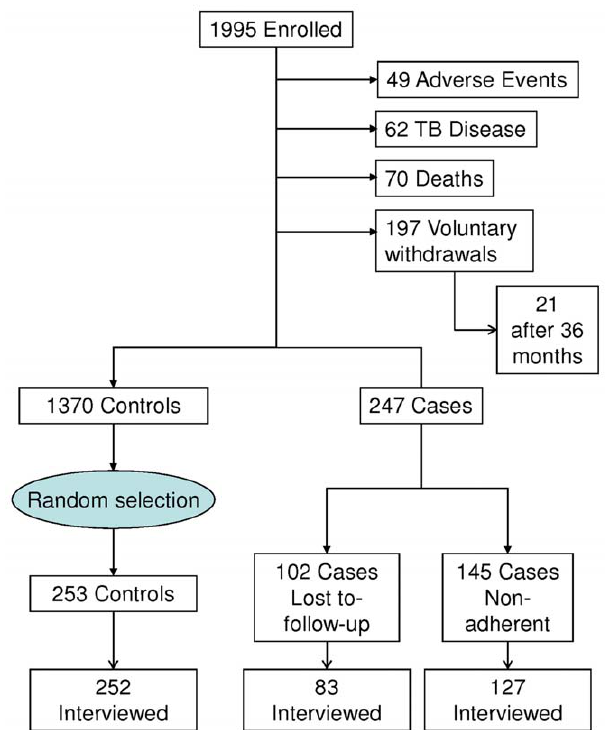
Figure 1. Derivation of cases and controls for the adherence sub-study from the cohort of HIV-infected persons enrolled in the Botswana Isoniazid Preventive Therapy Trial, 2004 – 2008. Case-Non-adherent was defined as not taking the study medication due to unwillingness to take any more study medication but continuing to attend quarterly visits and seen at the last expected visit. Case-LosT to follow-up was defined as a participant who was still expected to take the study medication and receive monthly medication refills but missed the last visit by $ 60 days. A control was defined as a participant who continued to be on study medication and was last seen within the expected visit window which was 7 days early or 14 days late in the 30- day study month. The median number of days since the last visit of those cases who were lost to follow-up was 396 days (range 91–1196), and 48 days (range 6–116) for the cases who were non-adherent. As the OBSERVATION AND HAD VOLUNTARILY WITHDRAWN.